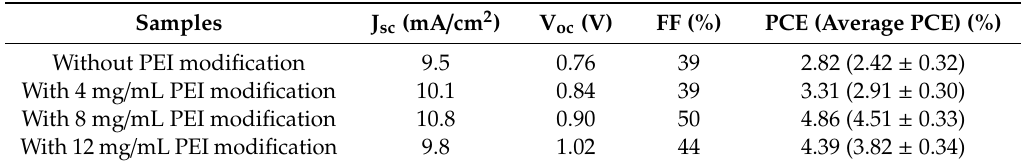
Table 1. Summary of the performance parameters of CsPbIBr 2 PSCs prepared without and with different concentrations of the PEI solution.